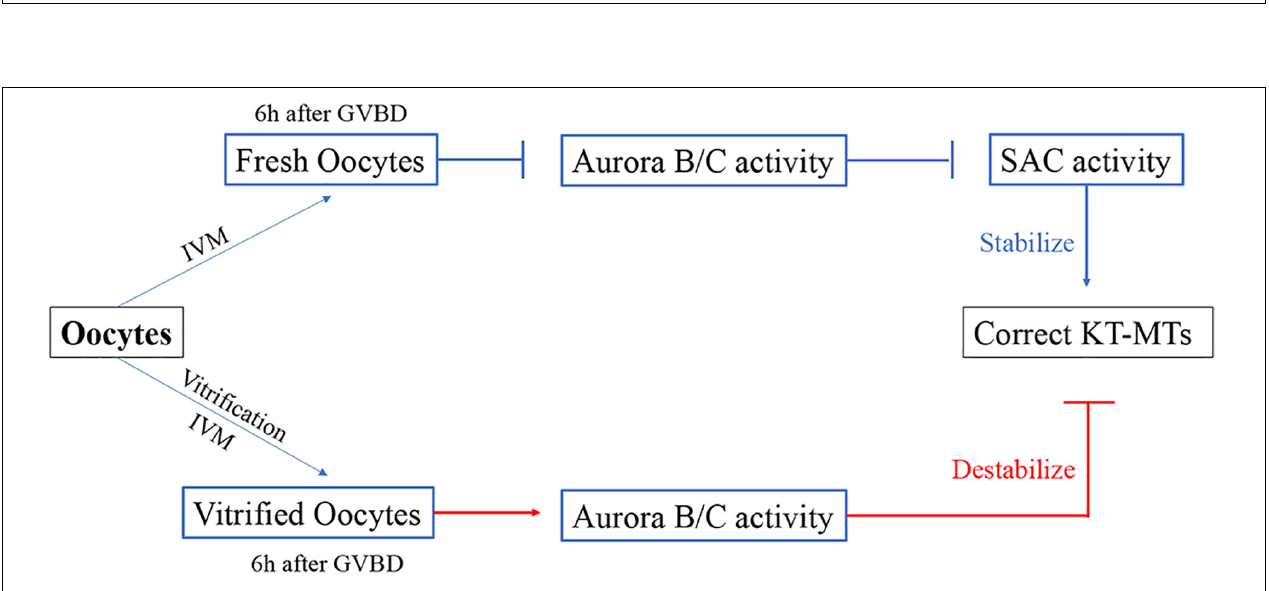
FIGURE 6 | Model for the formation of incorrect KT-MTs in vitrified oocytes. The Aurora B/C activity were significantly increased when bivalents were markedly stretched at 6h after GVBD. This Aurora B/C activity could not induce a SAC response, as the SAC protein Mad2 was significantly decreased during MI stage in vitrified oocytes. Thus, the KT-MTs were error-prone in vitrified oocytes.